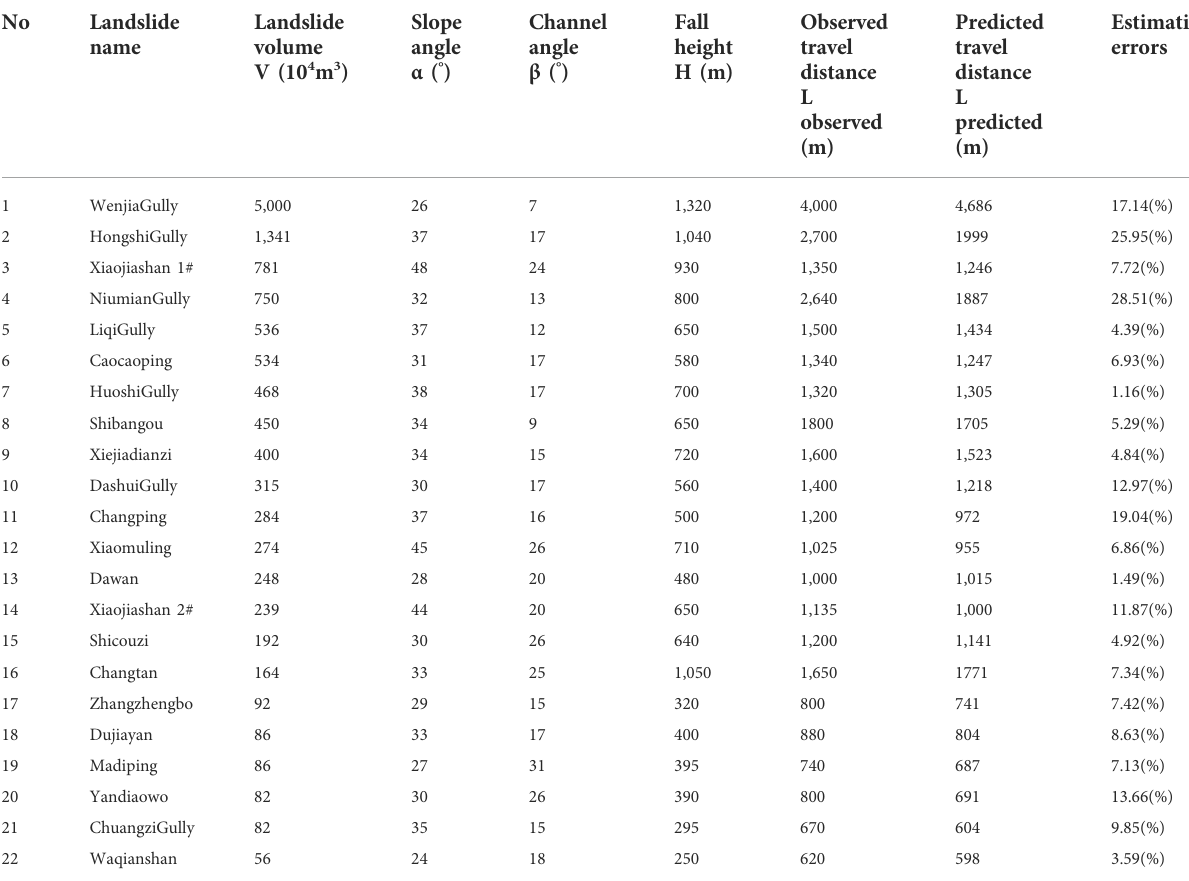
TABLE 1 The database of laterally con fi ned rock